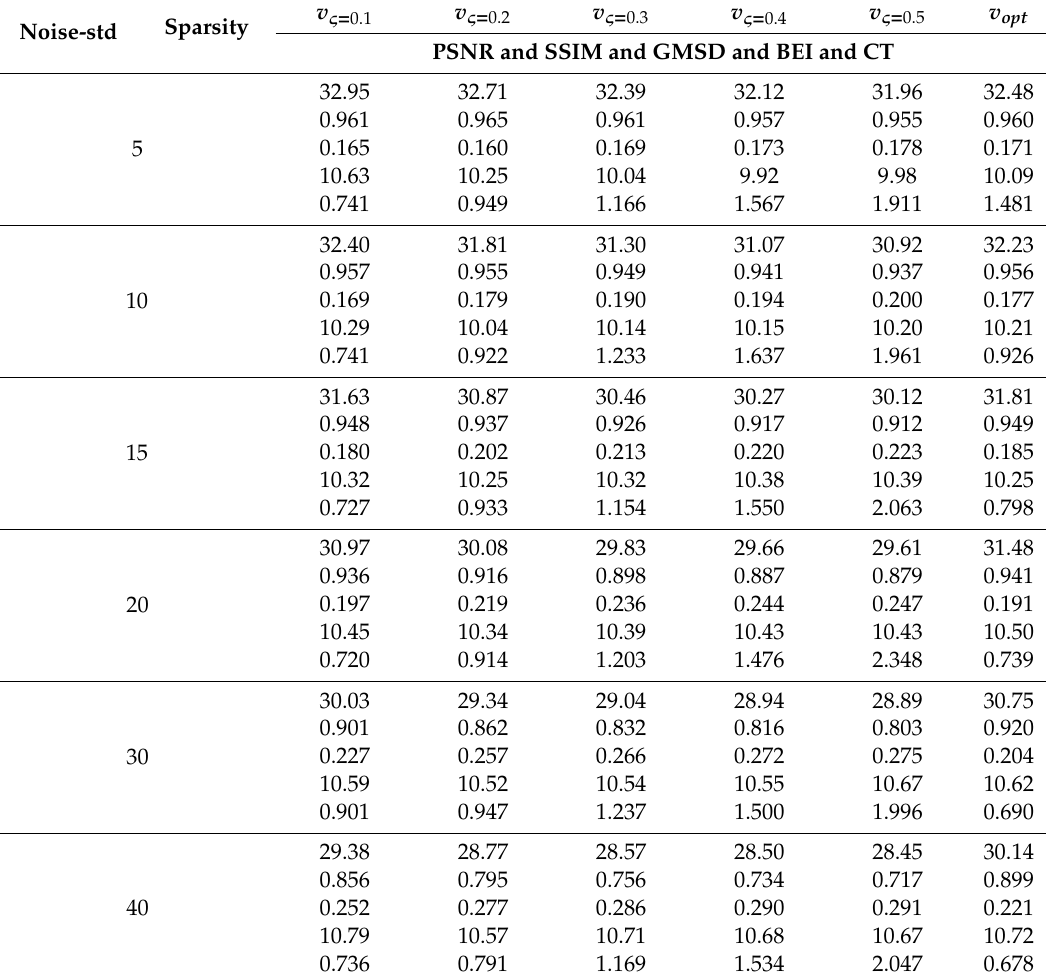
Table 3. The experimental results of Lena at di ff erent stop conditions and noise background (TSR = 0.4).